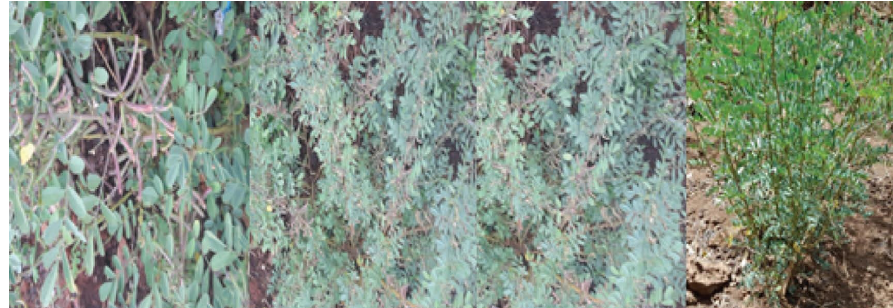
Figure 5: Indigo cultivating research project at EiTEX, Bahir Dar University, Ethiopia.